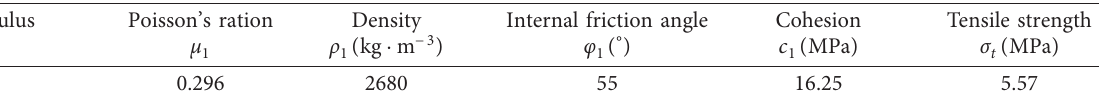
Table 2: Physical and mechanical parameters of the limestone rock.